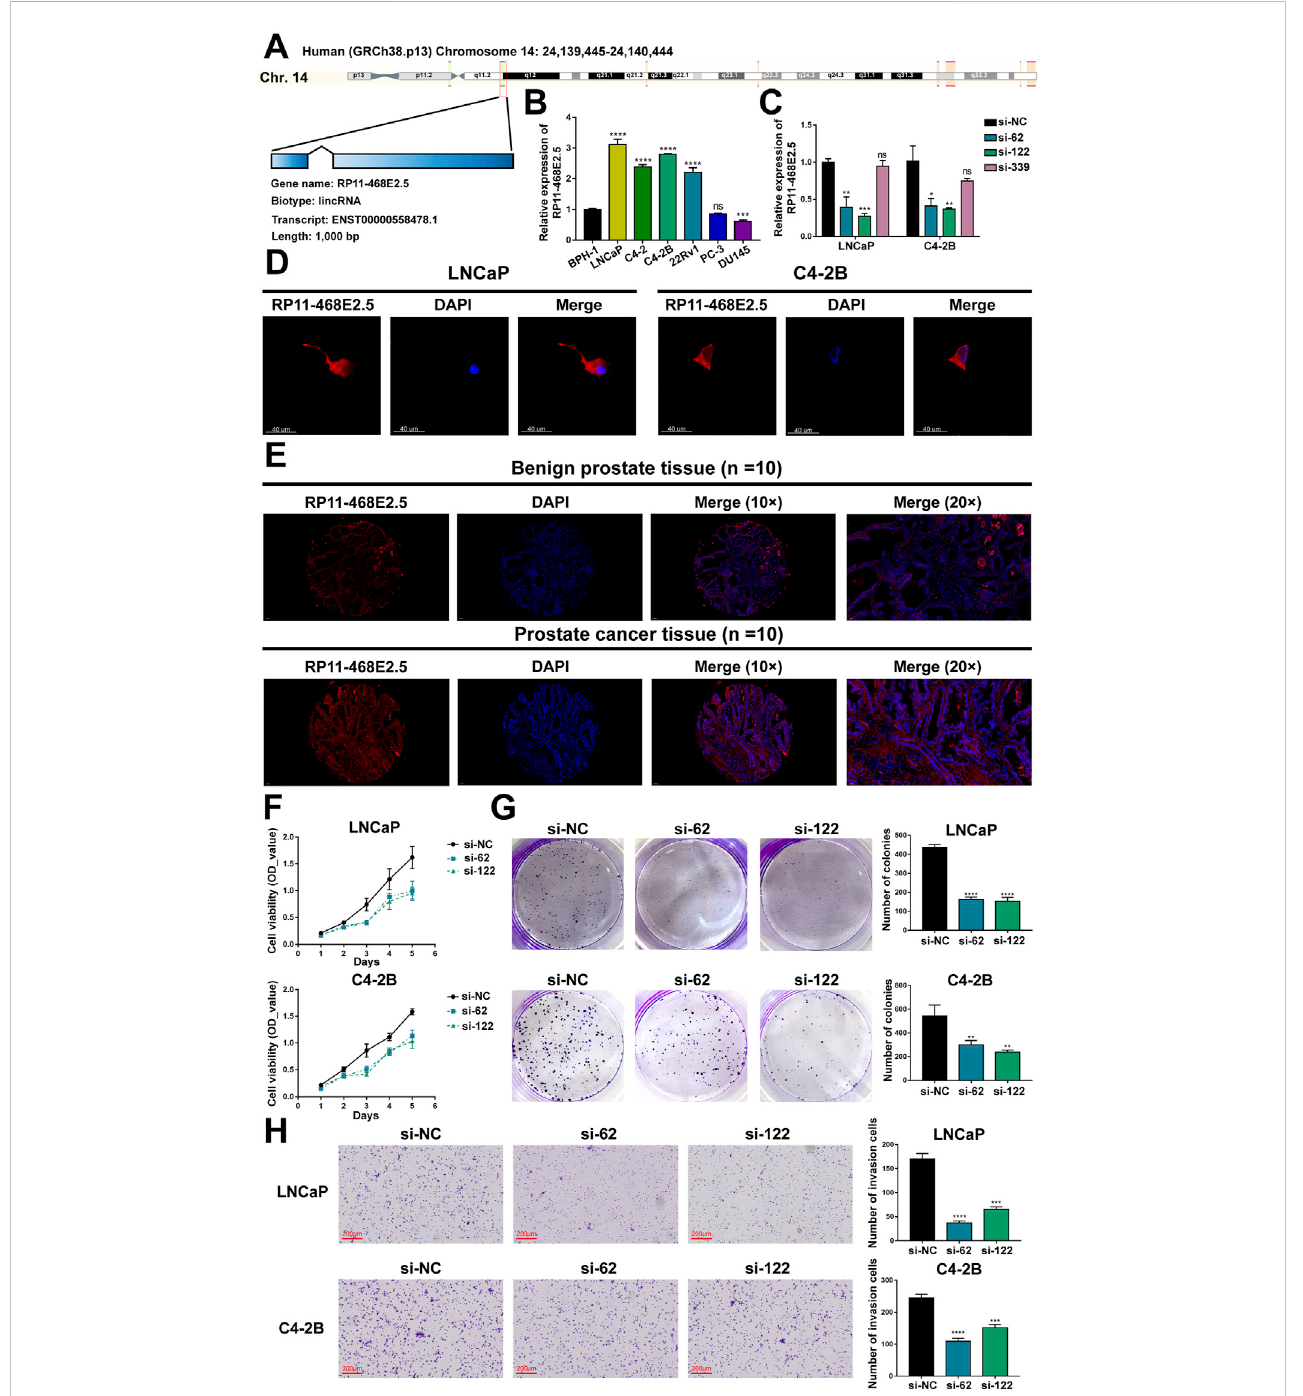
FIGURE 7 Experimental validation of RP11-468E2.5 ’ s cancer-promoting effects on PCa. (A) The gene information of RP11-468E2.5. (B) The basal expressions of RP11-468E2.5 in six PCa cell lines and one normal prostate cell line (BPH-1). (C) The gene-silencing ef fi ciencies of three siRNAs in LNCaP and C4-2B PCa cell lines. (D) The fl uorescence insitu hybridization(FISH)assays illustrated that RP11-468E2.5mainlyexistsinthecytoplasmicpartofLNCaP andC4-2Bcelllines. (E) FISH assayscon fi rmedthat RP11-468E2.5ishighly expressedintumortissue compared tobenignprostate tissue. (F) Theproliferation(CCK-8)assays showed silencing RP11-468E2.5 compromised cell viability in LNCaP and C4-2B cell lines. (G) The plate colony formation assays demonstrated downregulating RP11-468E2.5 attenuated cell viability in LNCaP and C4-2B cell lines. (H) The transwell assay showed silencing RP11-468E2.5 hampered PCa cells ’